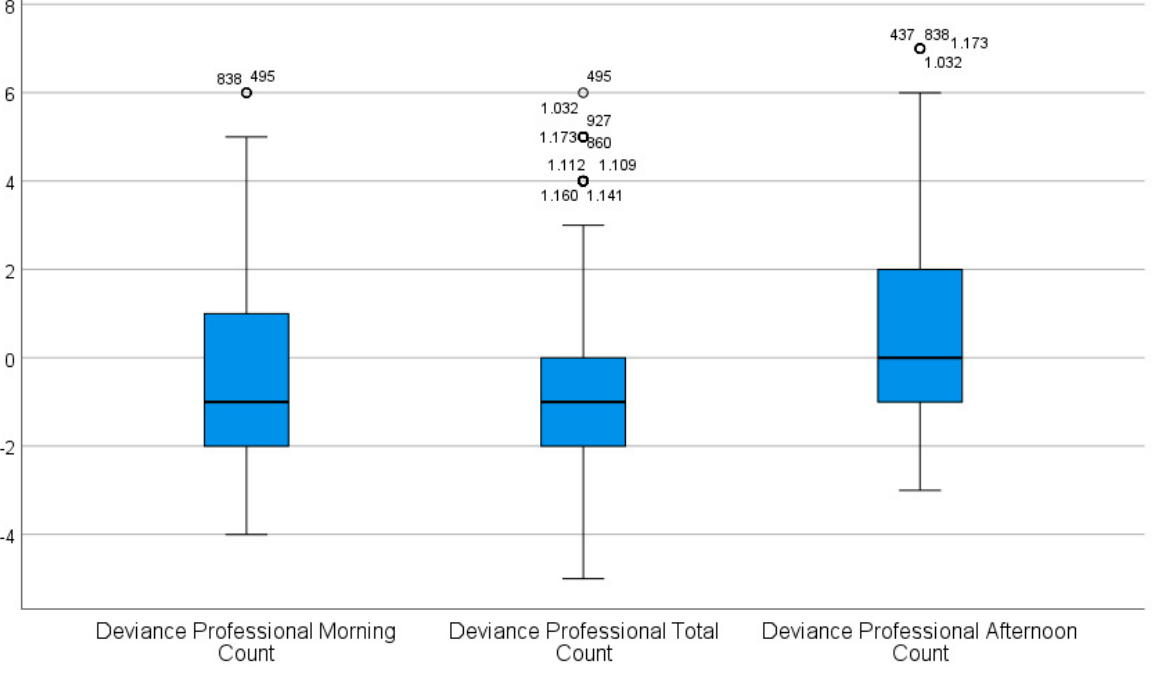
counts. On the individual level, respondents underestimated the morning and total count by about